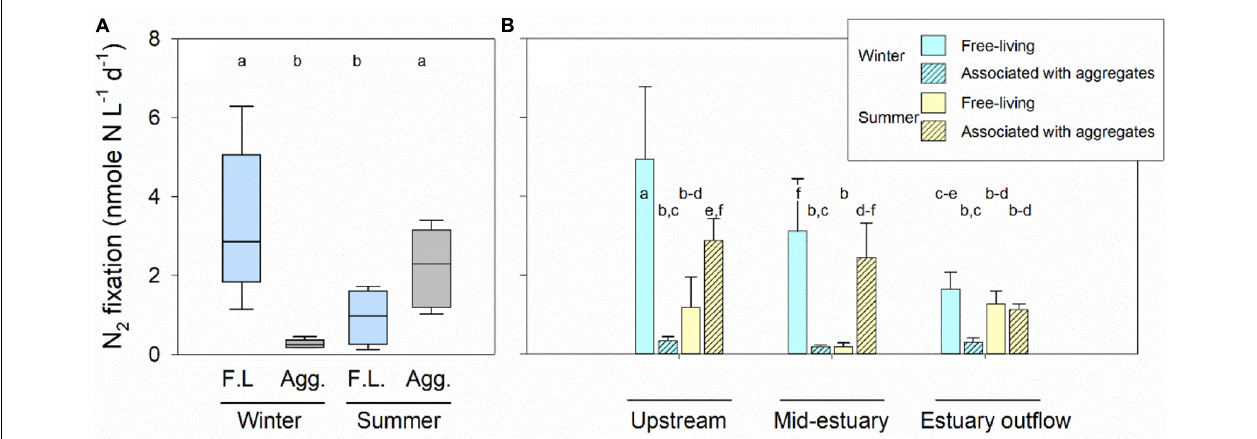
FIGURE 2 | Spatiotemporal changes in heterotrophic N 2 fixation along the Qishon River. N 2 fixation rates by free-living (F.L., blue) and aggregate-associated (gray) diazotrophs were averaged from all the sampling locations in winter and summer (A) . Spatial N 2 fixation represent the rates measured from each sampling location in both seasons (B) . The letters above the boxplots ( n = 9) and bars ( n = 3) represent the statistical difference between samples (ANOVA, Fisher LSD post hoc test, P < 0.05).